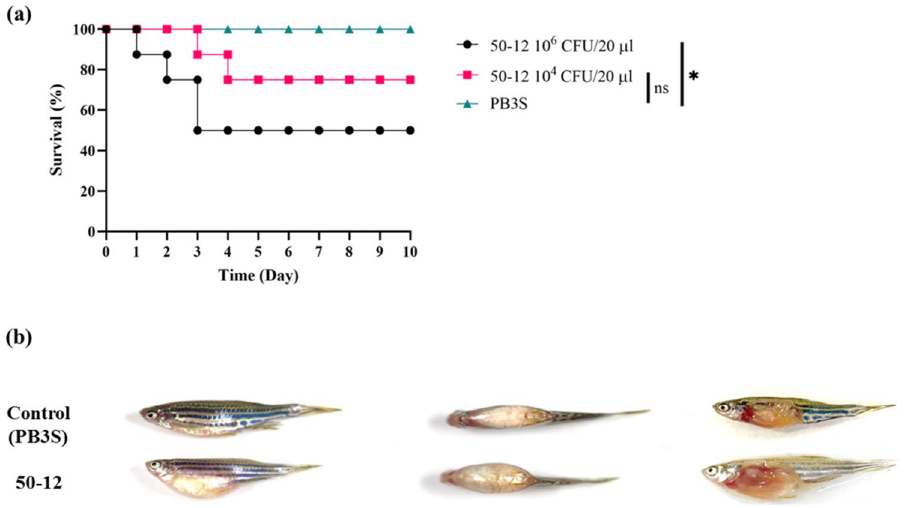
Figure 1. Pathogenicity of V. owensii GRA50-12 was confirmed by using zebrafish as a model. ( a ) Three groups (8 fishes/group) were considered, and their survival rates were measured after intraperitoneal injection of V. owensii GRA50-12 cells (2.2 × 10 6 CFU/20 µl, black line; 2.2 × 10 4 CFU/20 µl, red line) or PB3S (PBS with 3% NaCl) as control (green line). The X-axis represents the time post-infection and the Y-axis represents the survival percentage of the zebrafish. ( b ) The disease symptoms in V. owensii GRA50-12 infected zebrafish. Control represents PB3S buffer injected fish; thus, no symptoms were observed. 50-12 represents zebrafish injected with GRA50-12 and these showed swollen abdomen and bleeding at body surface (left: side view; middle: top view; right: abdomen anatomy). The anatomical analysis showed swollen and bleeding intestines. The significance of the differences between groups was performed by Log-rank and Gehan–Breslow–Wilcoxon test in GraphPad Prism 9. “*” indicates p <